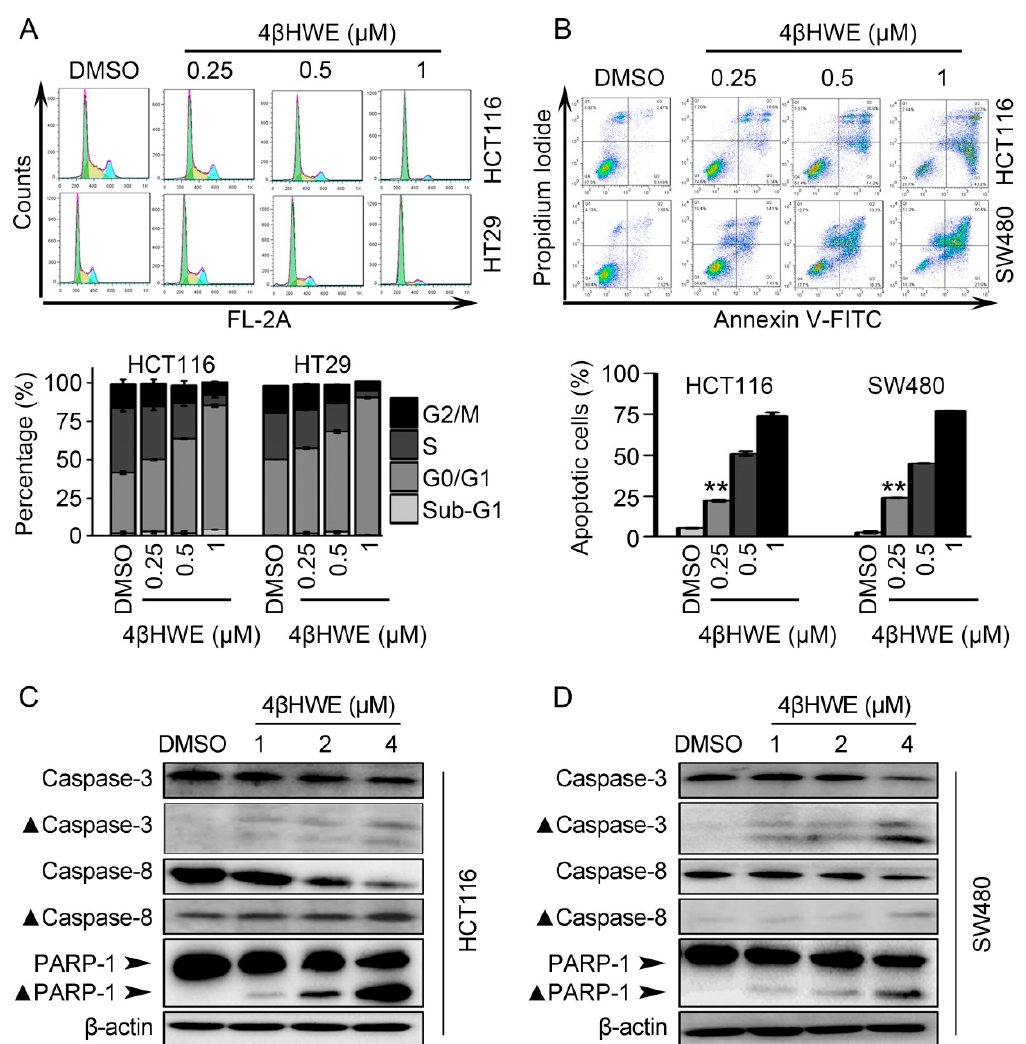
Figure 5. 4 β HWE induced G0/G1 cycle arrest and apoptosis in CRC. ( A ) HCT116 and HT29 cells were treated with indicated concentrations of 4 β HWE for 24 h respectively, and the distribution of the cell cycle was documented. ( B ) Cells were treated with 4 β HWE for 48 h, stained with Annexin V-FITC and PI, and analyzed by flow cytometry. P -values were derived from the Student’s t-test (* p < 0.05, ** p < 0.01). HCT116 ( C ) and SW480 cells ( D ) were treated with DMSO, 1, 2, and 4 µ M of 4 β HWE for 24 h, and the lysates were subjected to western blot analysis. The level of apoptosis-related proteins was detected.